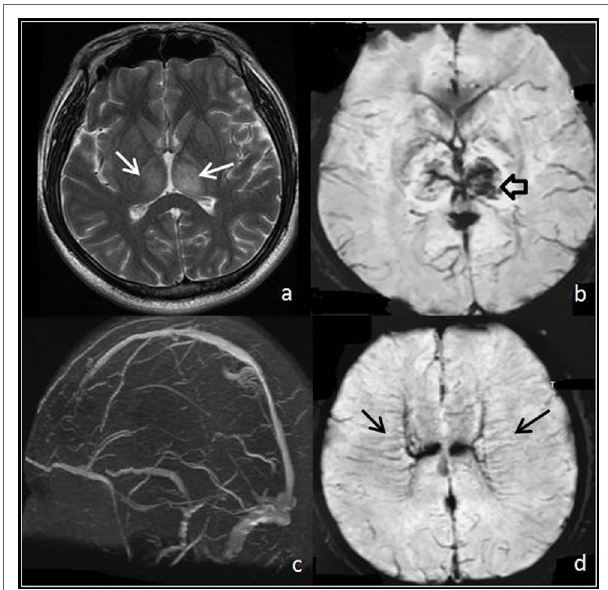
FigUre 2 | Thrombosis of deep venous system. (a,B) T2 and T2* images show focal edema (white arrows) and hemorrhage (hollow arrow) within both thalami. (c) MR venogram demonstrates a portion of the deep venous system with no signal, a finding consistent with occlusion. (D) T2* images show multiple linear abnormal signals within the deep white matter (black arrows), which demonstrate medullar veins dilated